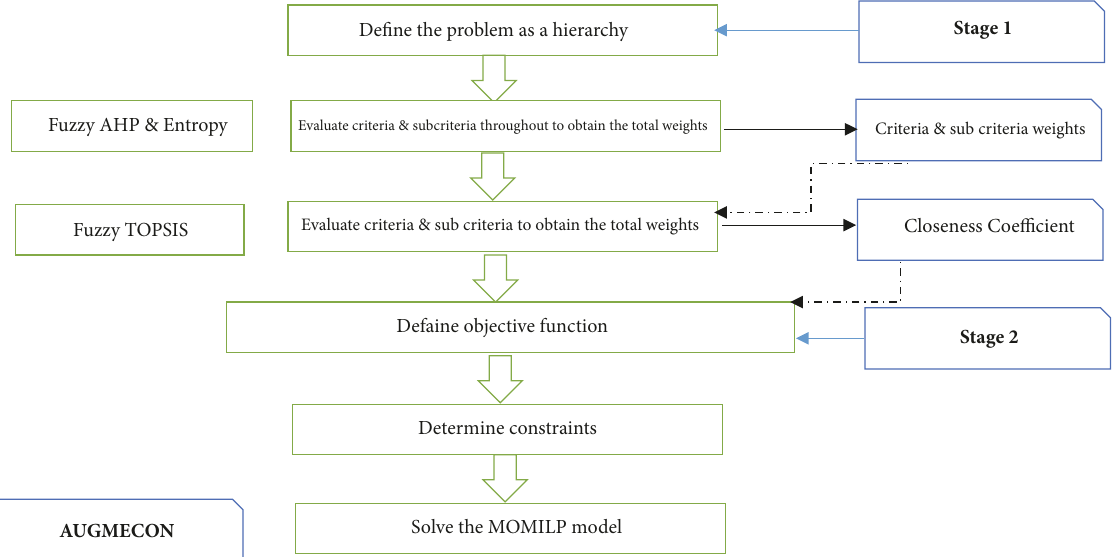
Figure 3: Hybrid fuzzy MCDM application integrated with facility layout problem for equipment selection in industrial application